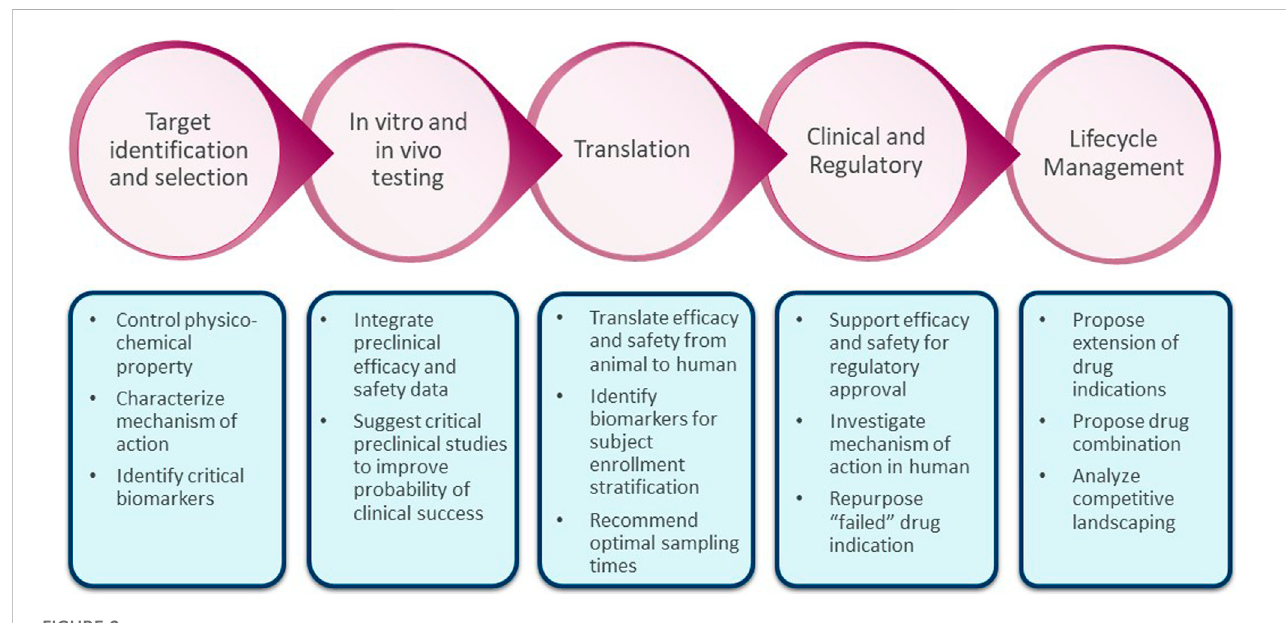
FIGURE 2 Applications of quantitative systems models throughout drug development